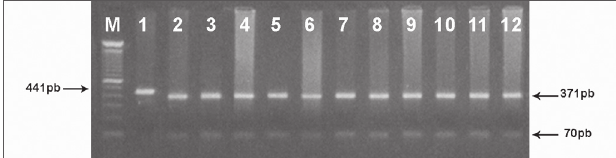
Figura 2. Rastreamento da mutação mitocondrial C1494T por PCR- RFLP. Um fragmento de 441pb foi clivado com a enzima de restrição Hph I. O DNA mitocondrial normal gera dois fragmentos de restrição (370pb e 71pb) e o mutante perde o sítio de restrição e não ’ clivado pela enzima (441pb). (M) - marcador de peso molecular